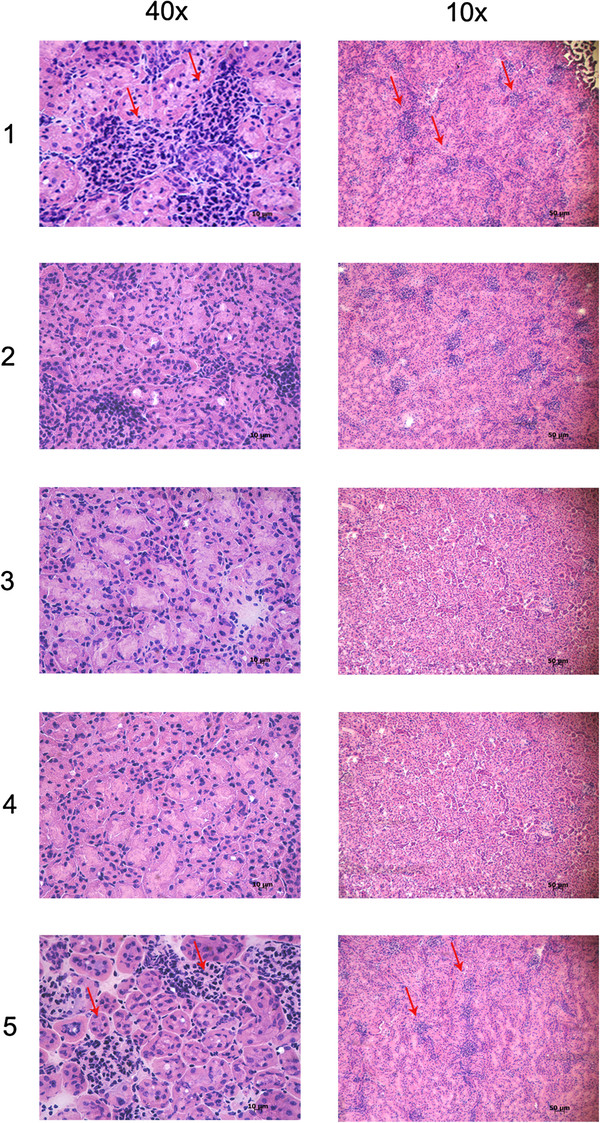
Haematoxylin eosin staining. Kidney sections from Staphylococcus epidermidis (108 CFU/mouse) infected mice after 3 or 9 hours (panel 1and 5); kidney sections from Staphylococcus epidermidis (108 CFU/mouse) infected mice after 3 hours and treated with MIX (RJI-C at 9 μg/mouse and TB-KK at 6 μg/mouse) for 3, 6 and 9 hours (panel 2–4).